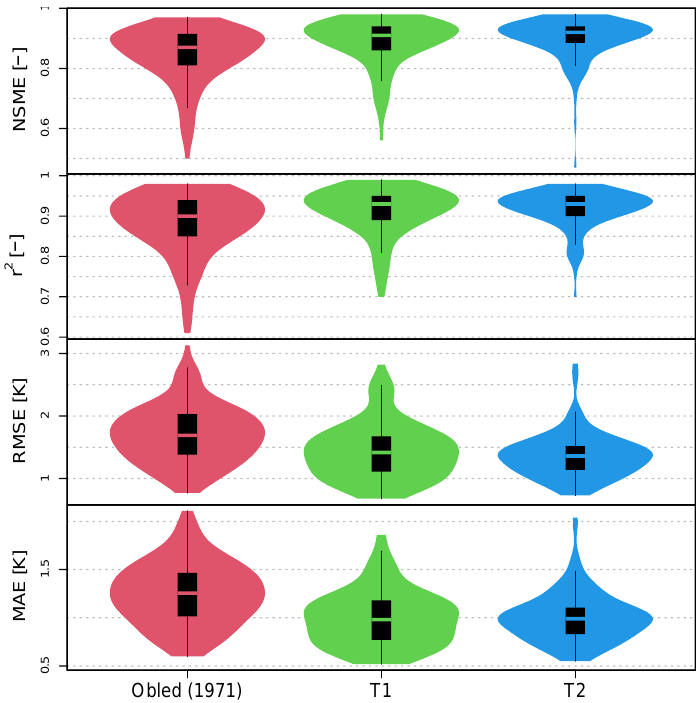
Figure 8. Comparison of efficiency criteria for new air temperature transfer functions.